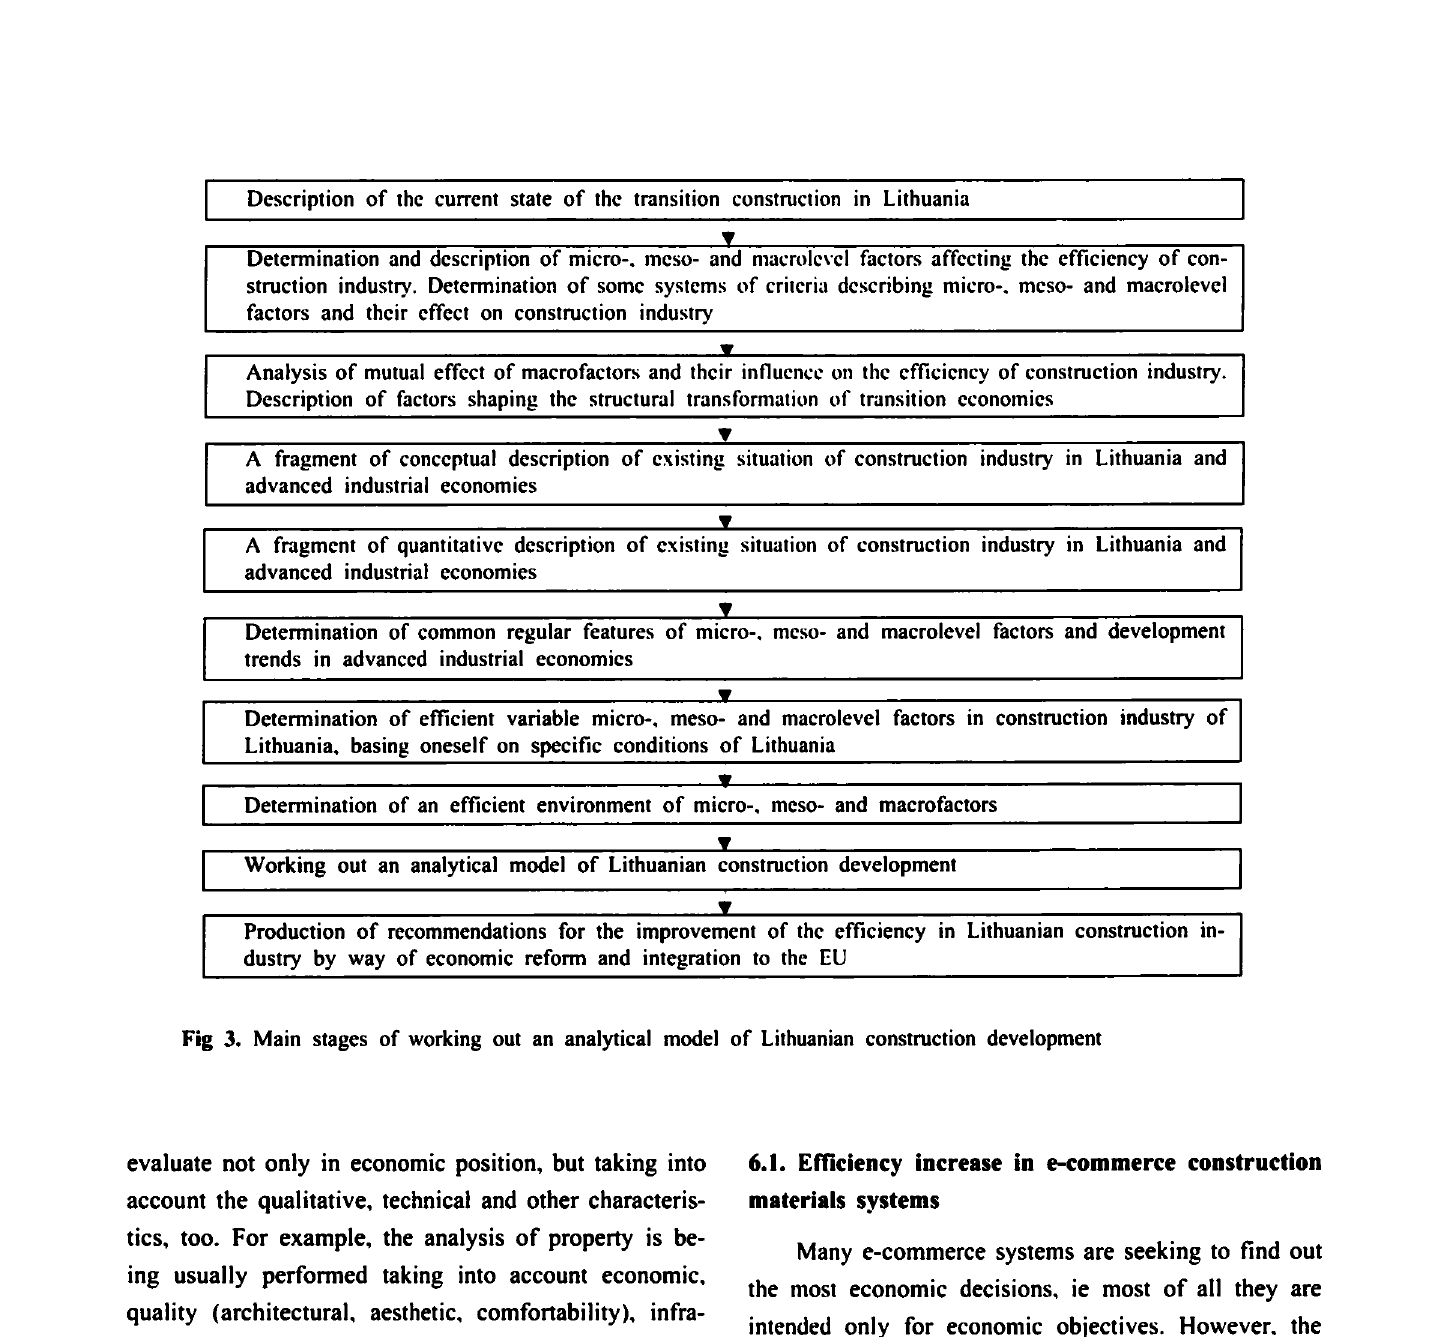
evaluate not only in economic position, but taking